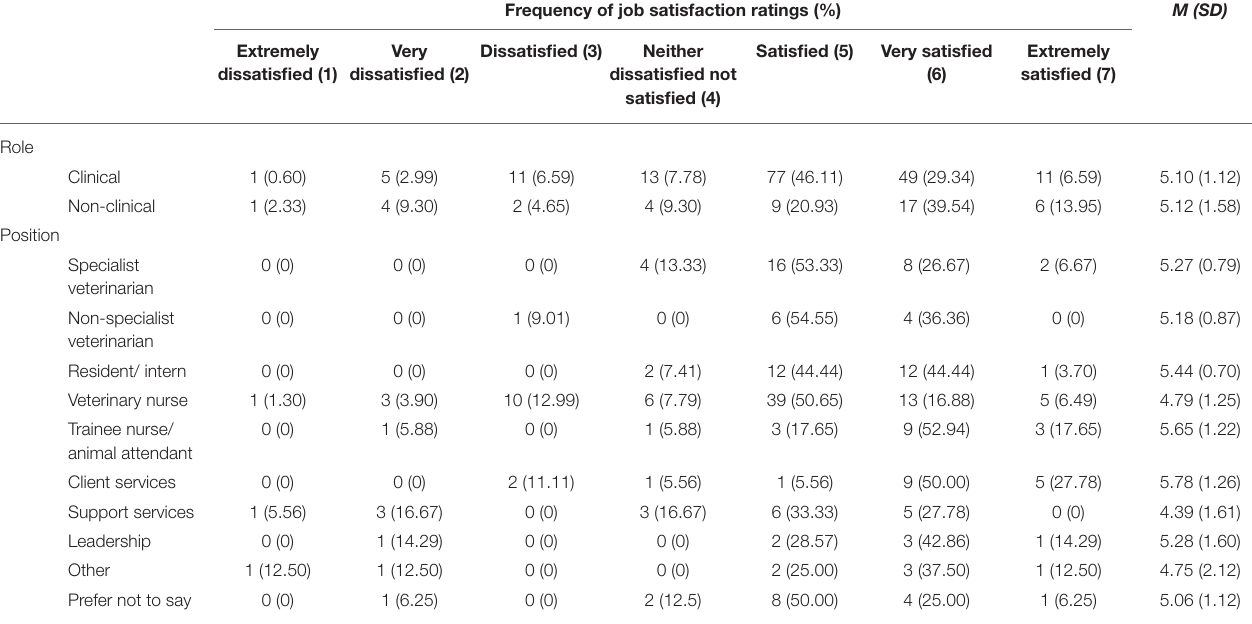
TABLE 2 | Job satisfaction by role and